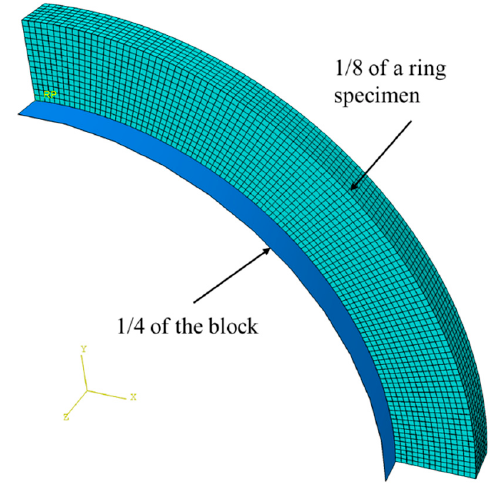
Figure 4. FE model with the mesh